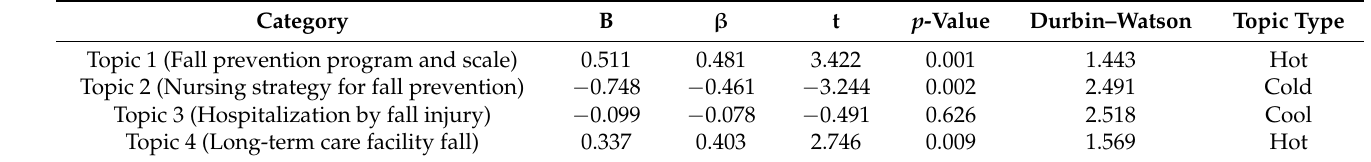
Table 3. Topic type by regression coefficient and significance